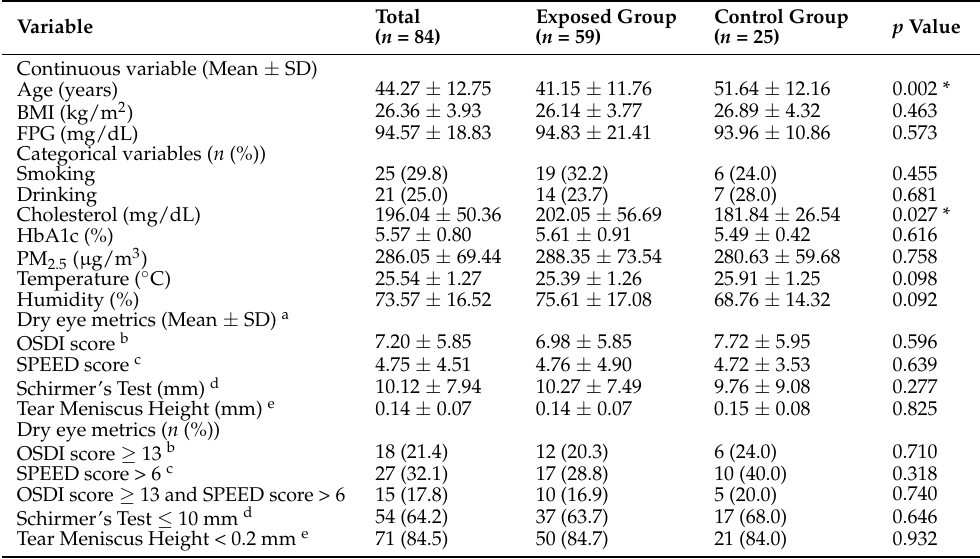
Table 1. Descriptive statistics of the study